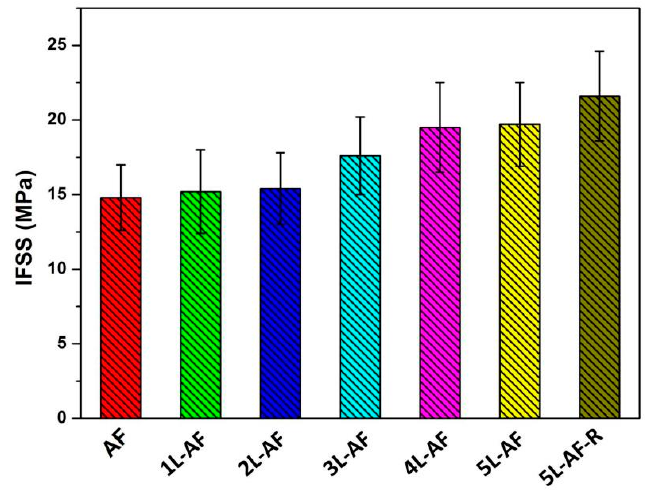
Figure 10. IFSS of aramid fibers/epoxy composites before and after treatment with layer-by-layer self-assembly of L -PDOPA and electrostatic adsorption acidification of silane coupling agents (KH550).